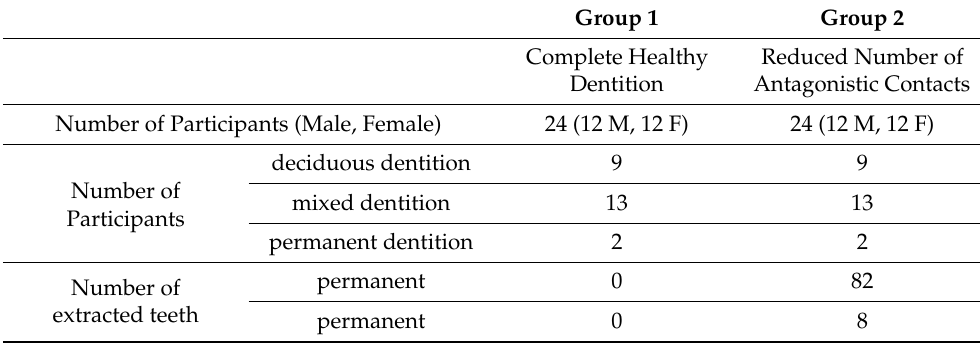
Table 1. Age, gender, dentition and number of participants.